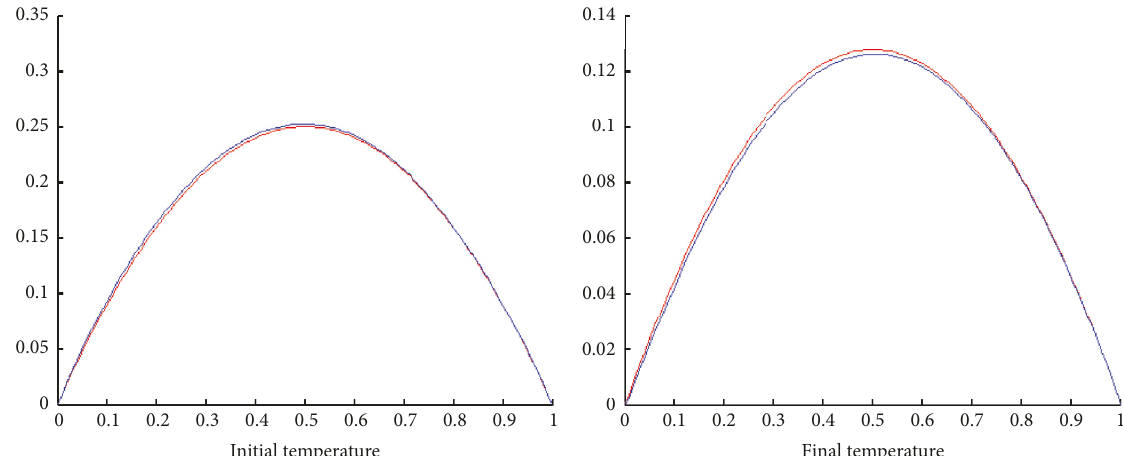
Figure 20: This figure shows that we can rebuild the